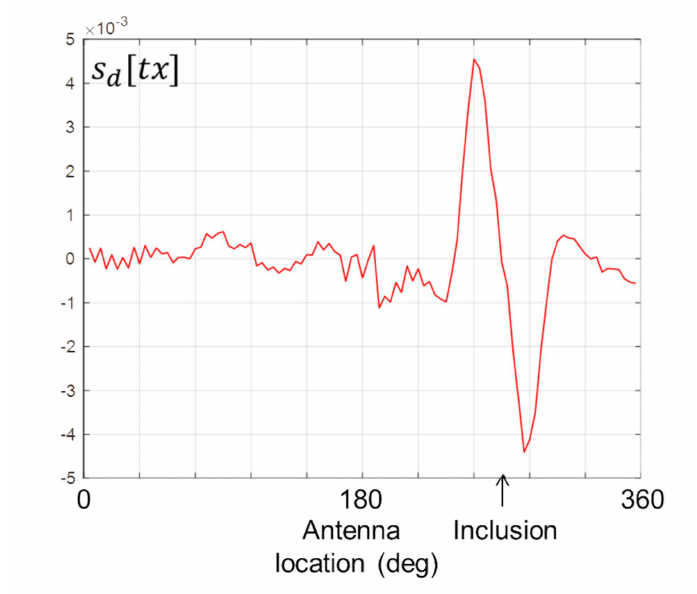
Figure 10. s d [ tx ] computed from Equation (6) for scan #1.